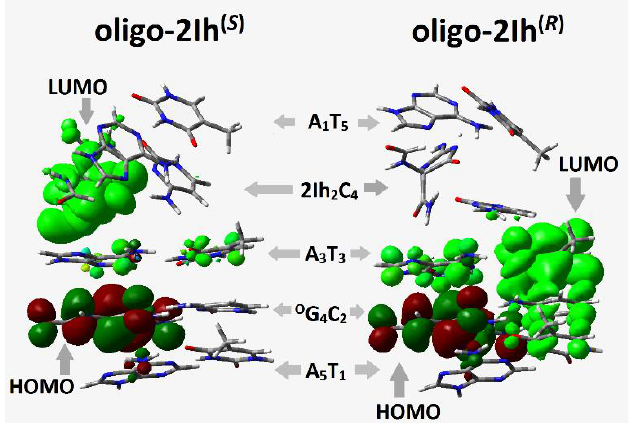
Figure 4. Graphical representation of the molecular orbital distributions (HOMO, LUMO) in neutral states of oligo-2Ih ( R ) and oligo-2Ih ( S ) calculated at the M062x/6-31++G** level of theory in the aqueous phase.